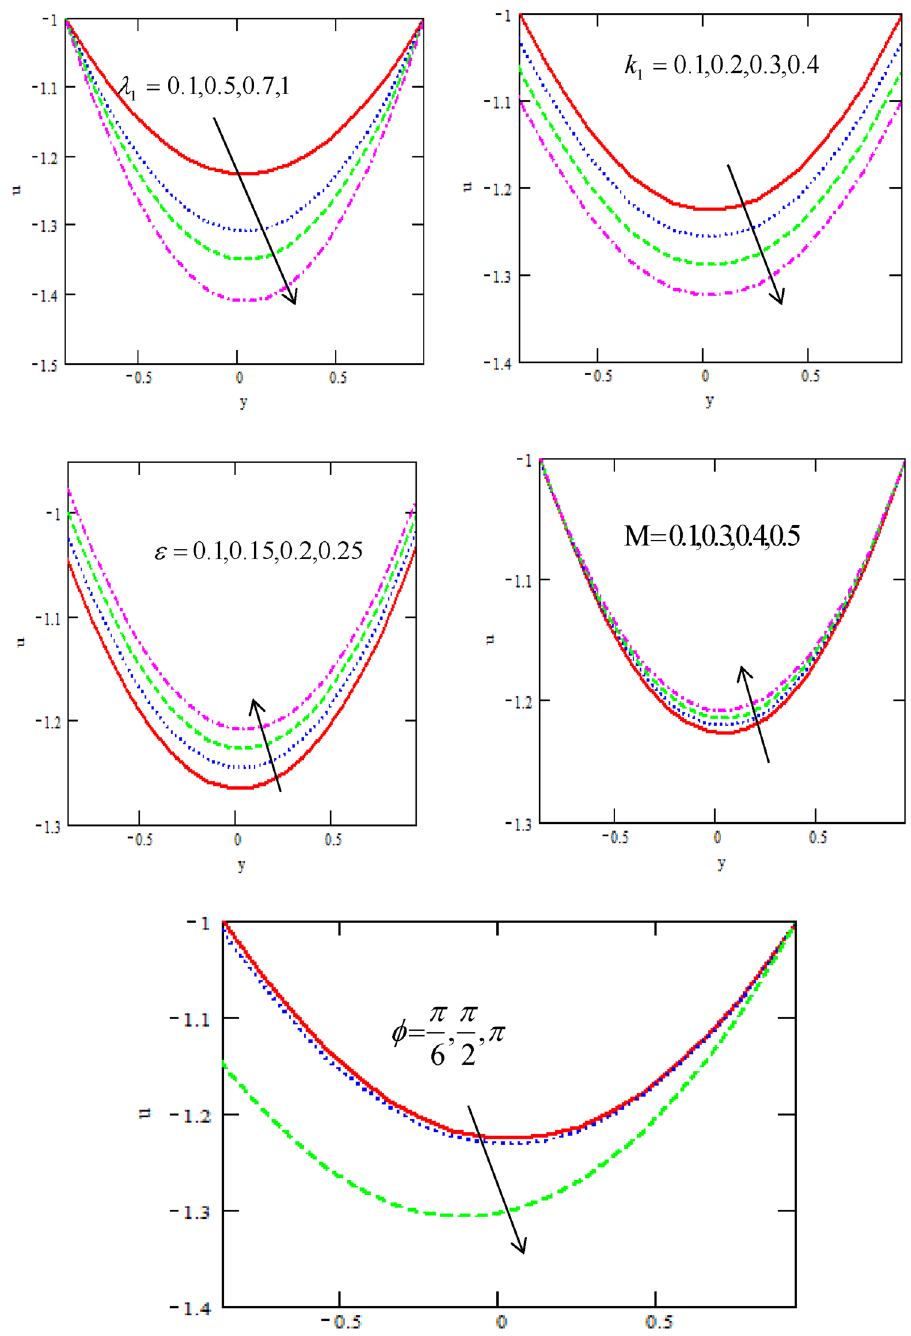
Figure 2. Variation of the velocity u concerning the axial-y with different values of (cid:31) 1 , k 1 , ε , M, ϕ